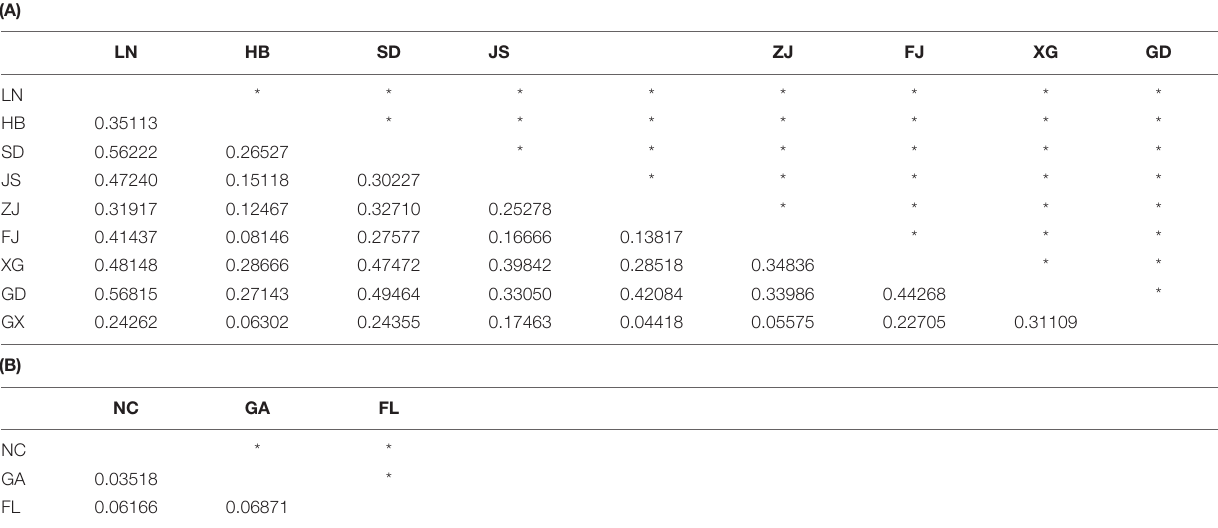
TABLE 5 | Genetic differentiation between populations of Spartina alterniflora at eight microsatellite